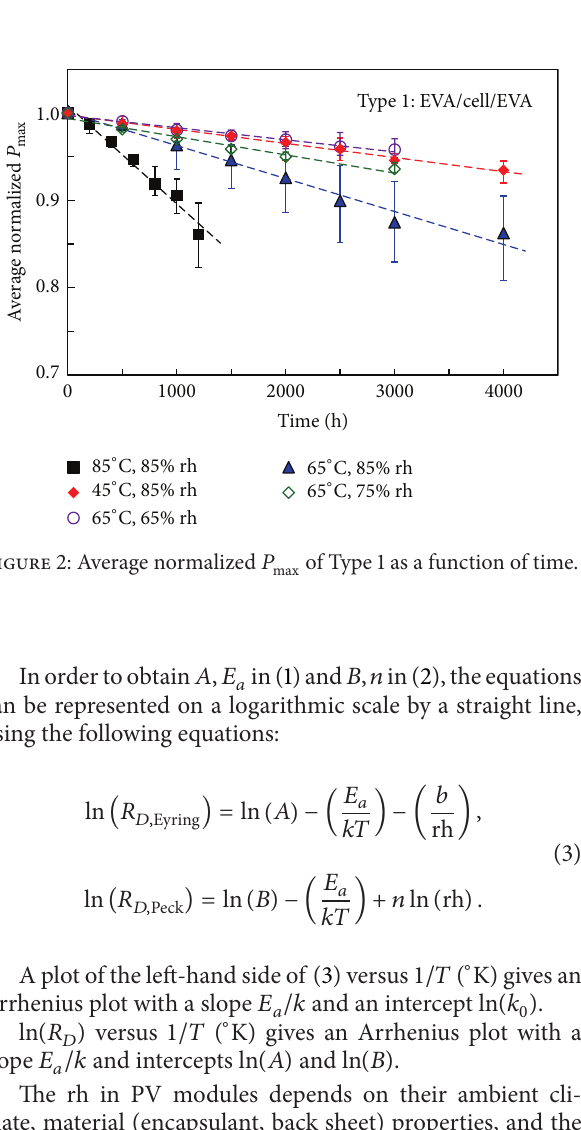
Figure 1: Test samples for DH tests: (a) PV module with EVA/cell/EVA structure (Type 1), (b) PV module with glass/EVA/cell/EVA/back sheet structure (Type 2).